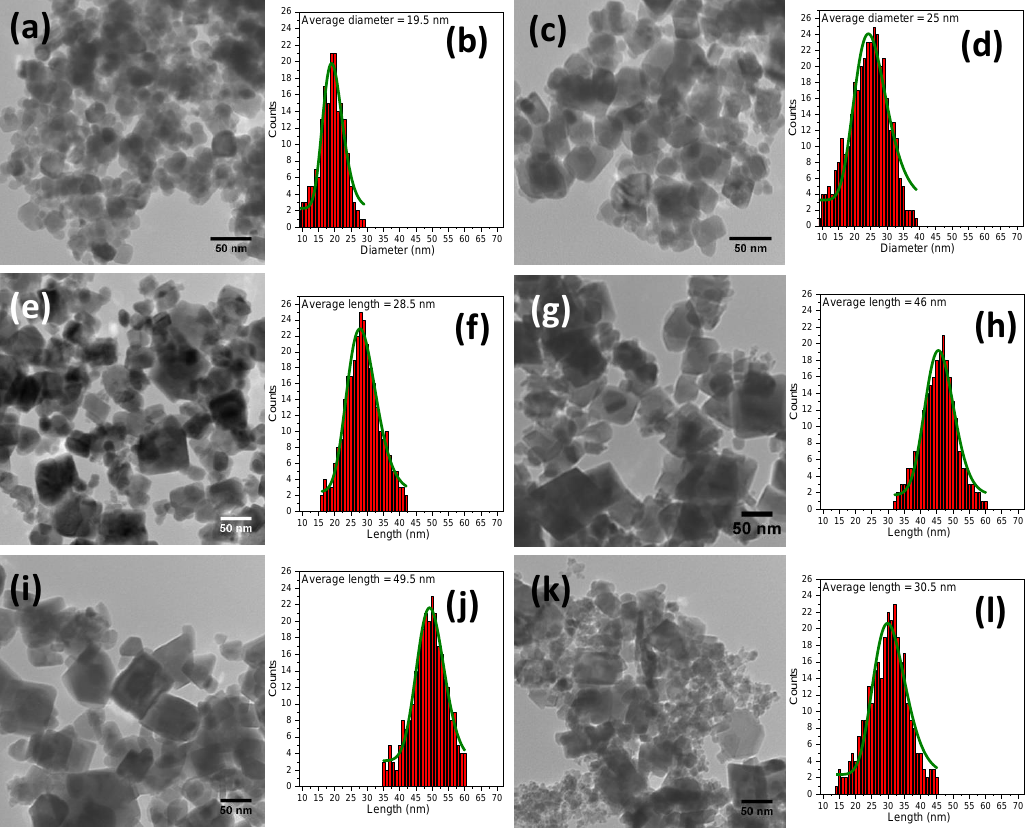
Figure 1. Large scale TEM images of MagNPs and their corresponding size distribution histograms fitted to a log-normal distribution (green lines) obtained by employing different amounts of NaAc in the synthesis: ( a , b ) 0.6 g; ( c , d ) 0.9; ( e , f ) 1.2 g; ( g , h ) 2.4 g; ( i , j ) 3.2 g; and ( k , l ) 4.8 g.